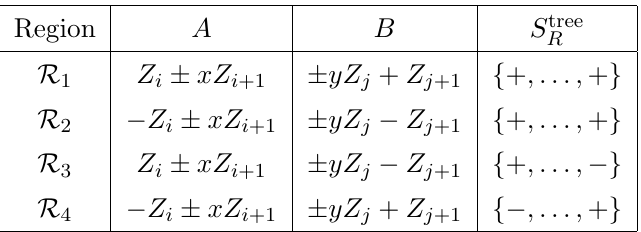
Table 2 . Parametrization of ( AB ) in the four